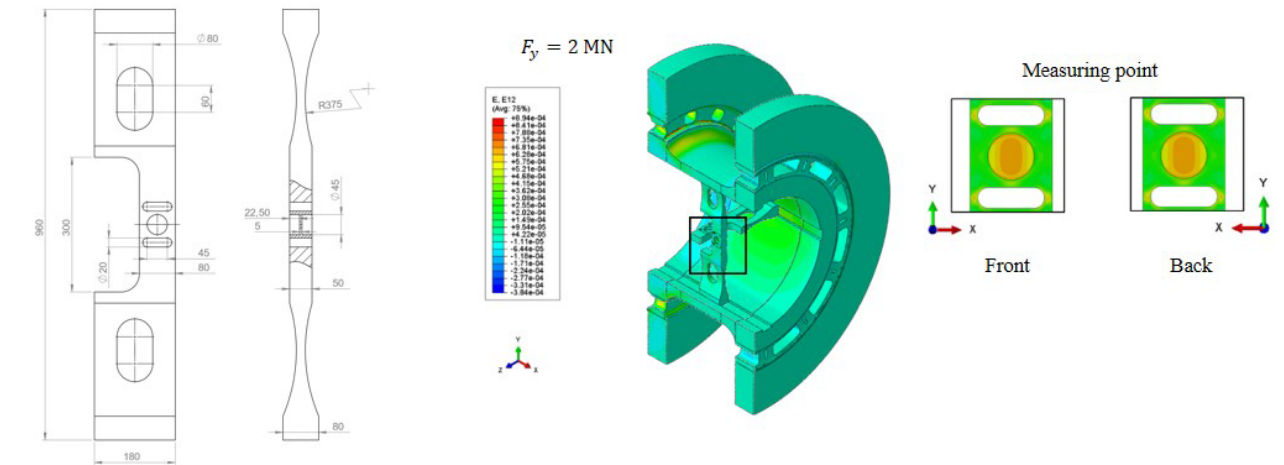
Figure 14. Lateral force element dimensions and the distribution of the shear strain in the x – y plane at the measuring point of lateral force under nominal lateral force of 2MN.